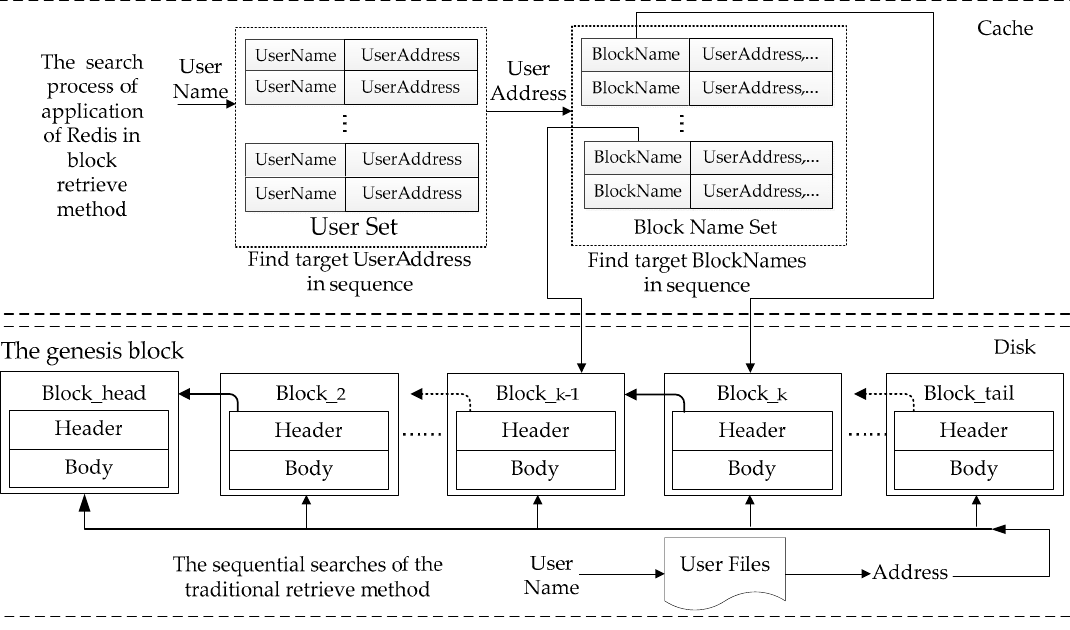
Figure 7. The di ff erences between two retrieval methods (the application of Redis in block retrieval method and the traditional retrieval method).